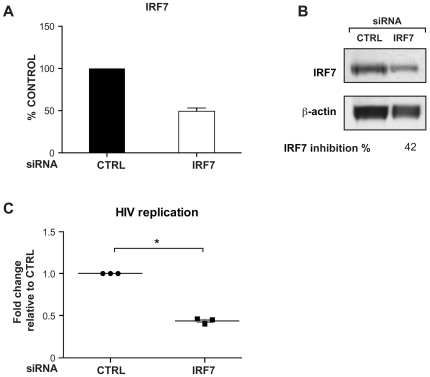
IRF7 expression modulates HIV-1 replication in primary macrophages.A) Level of IRF7 gene expression in macrophages treated with siRNA targeting IRF7 (50 nM) [n = 3] compared to a control non-targeted siRNA [n = 3] resulted in a 55% reduction in IRF7 gene expression. The qRT-PCR results were normalized to the level of 18 S. B) Western blot for IRF7 protein treated as in panel A shows a decrease of 42% for IRF7 protein. The densitometry of the bands was normalized to that of β-actin. Results shown are representative of 2 independent experiments. C) Level of TAT spliced expression following inhibition (51%) by IRF7 as compared to control. The qRT-PCR results were normalized to the level of 18 S. An * denotes a significant difference (P<0.001, one sample t-test) compared to the negative control siRNA. Each symbol in a group represents one independent donor.